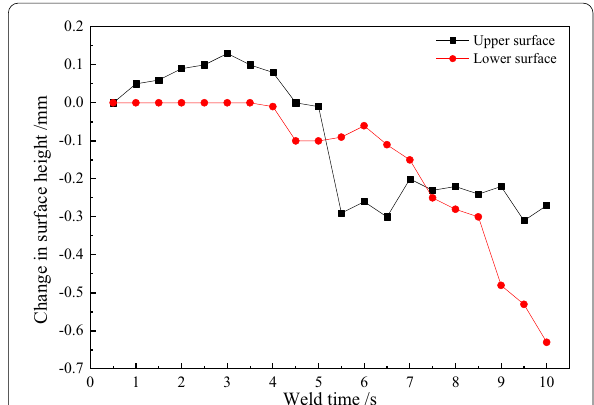
Figure 14 Variation in upper and lower surface heights of stationary DC GTA welding